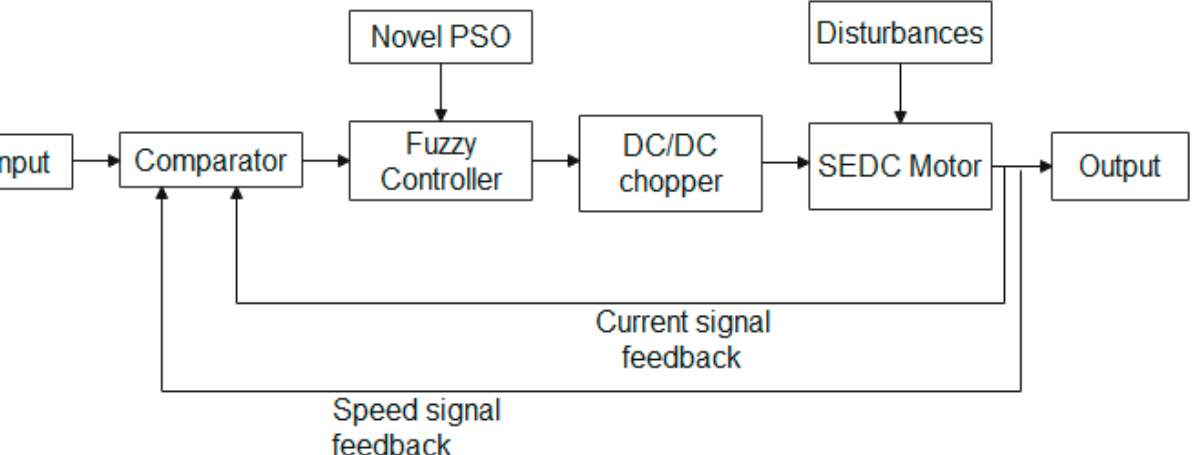
Figure 4. Block diagram of the proposed controlling scheme for SEDC motors.